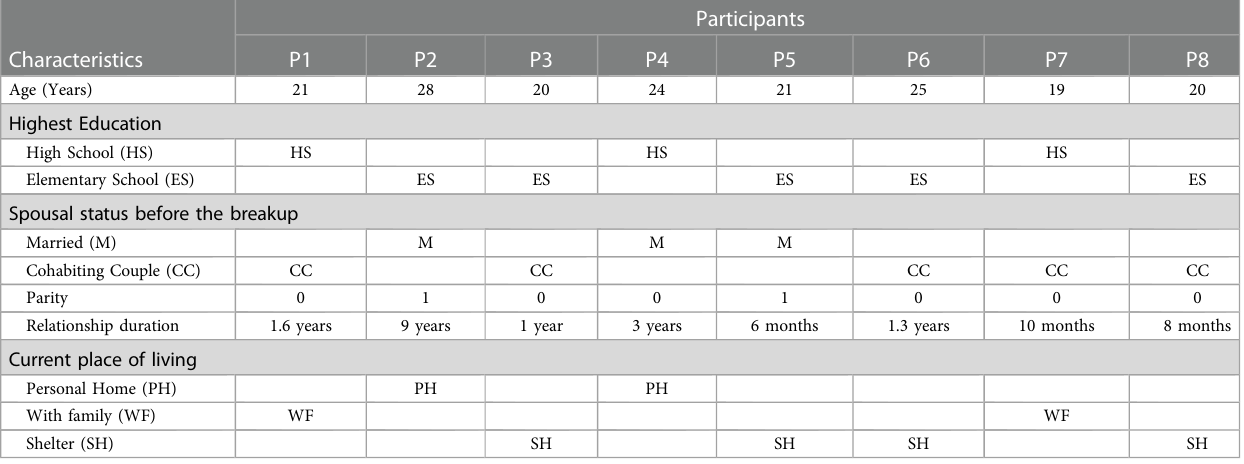
TABLE 1 Background pro fi le of the study participants, March 2021, Hawassa, Ethiopia, ( n =8).